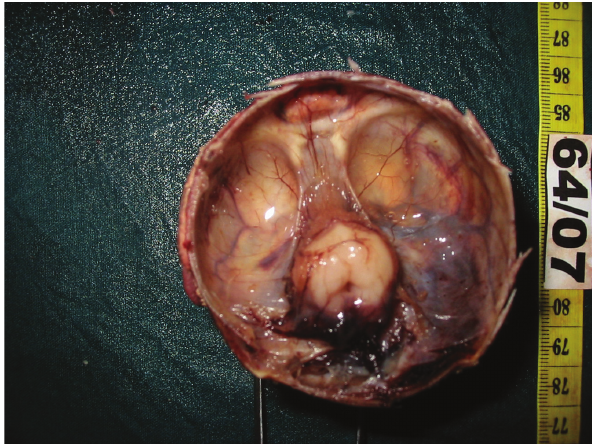
Figure 2: Atelencephalic